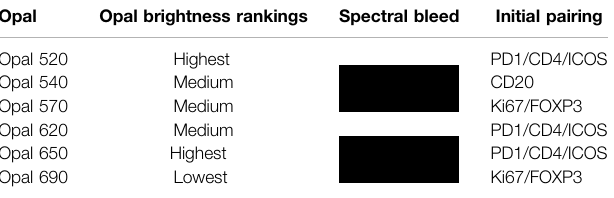
The table shows the strategy used for antibody-Opal pairing. The co-localized surface markers (PD-1, CD4 and ICOS) were associated with the brightest Opals using the rankings on the Vectra Polaris scanner. The markers not expressed in the same cellular compartment were associated with Opals that are more subject to spectral bleed with the Vectra Polaris scanner (black